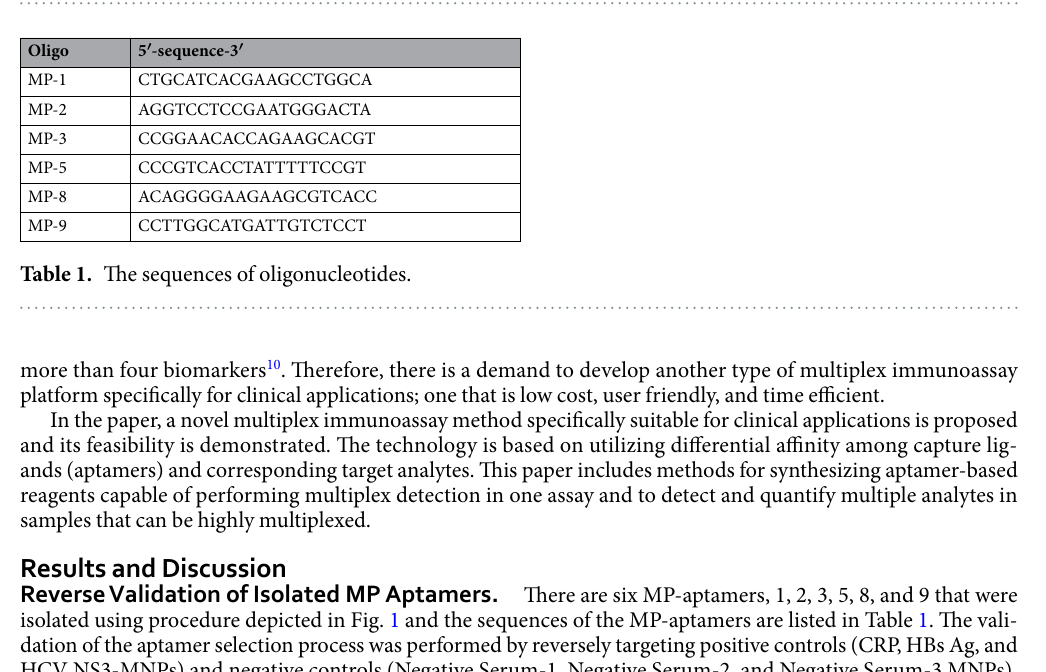
Figure 1. Schematic drawing to illustrate the selection process for aptamers capable of conjugating multiple target analytes having different affinity using the MARAS procedure.